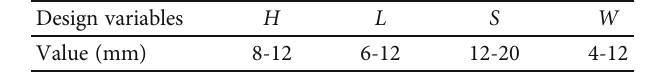
Figure 9: Friction factors and Nusselt numbers as a function of angle γ . Table 3: Ranges of design variables.